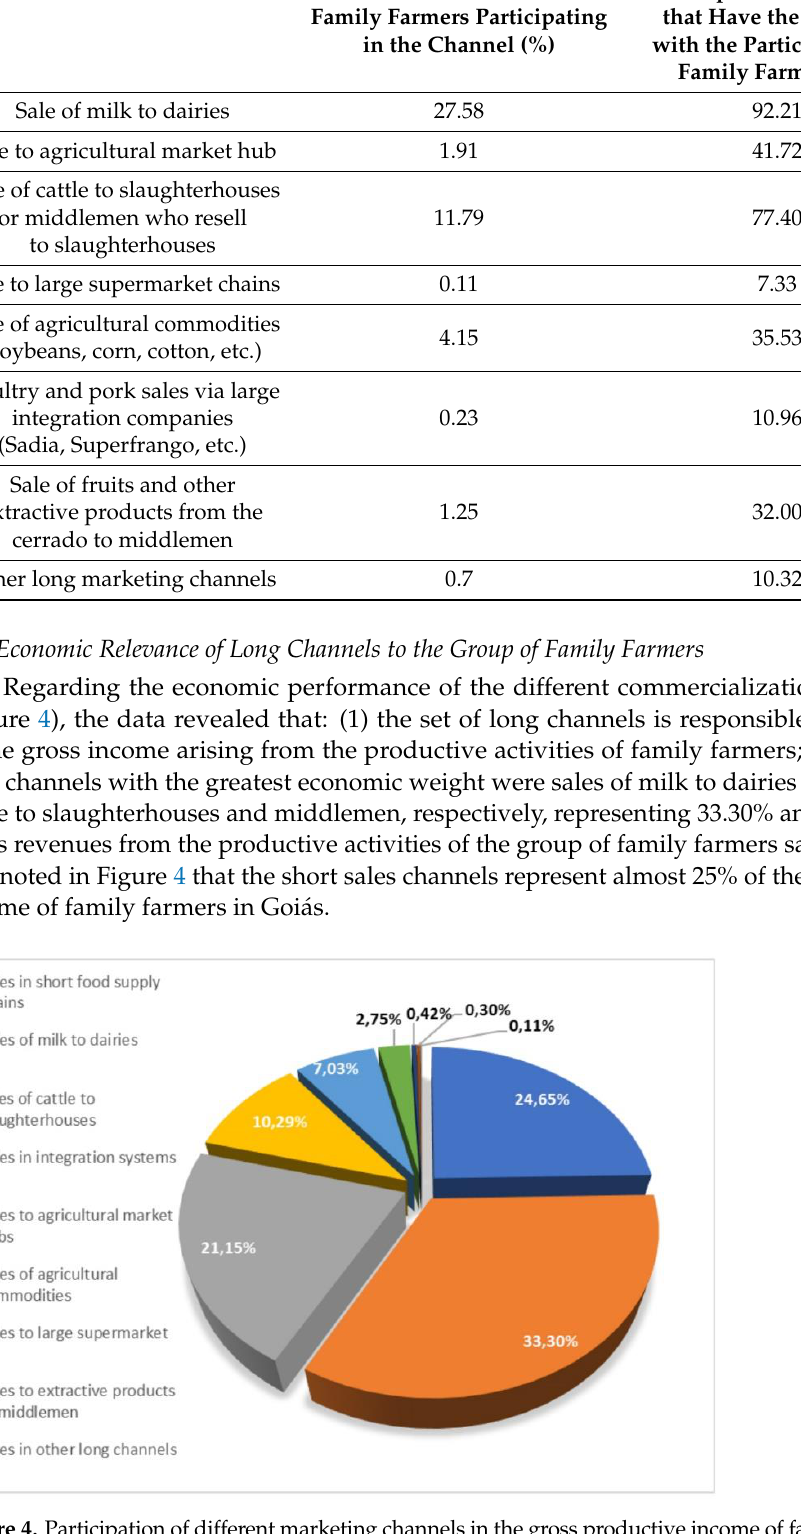
Figure 4. Participation of different marketing channels in the gross productive income of family farmers.